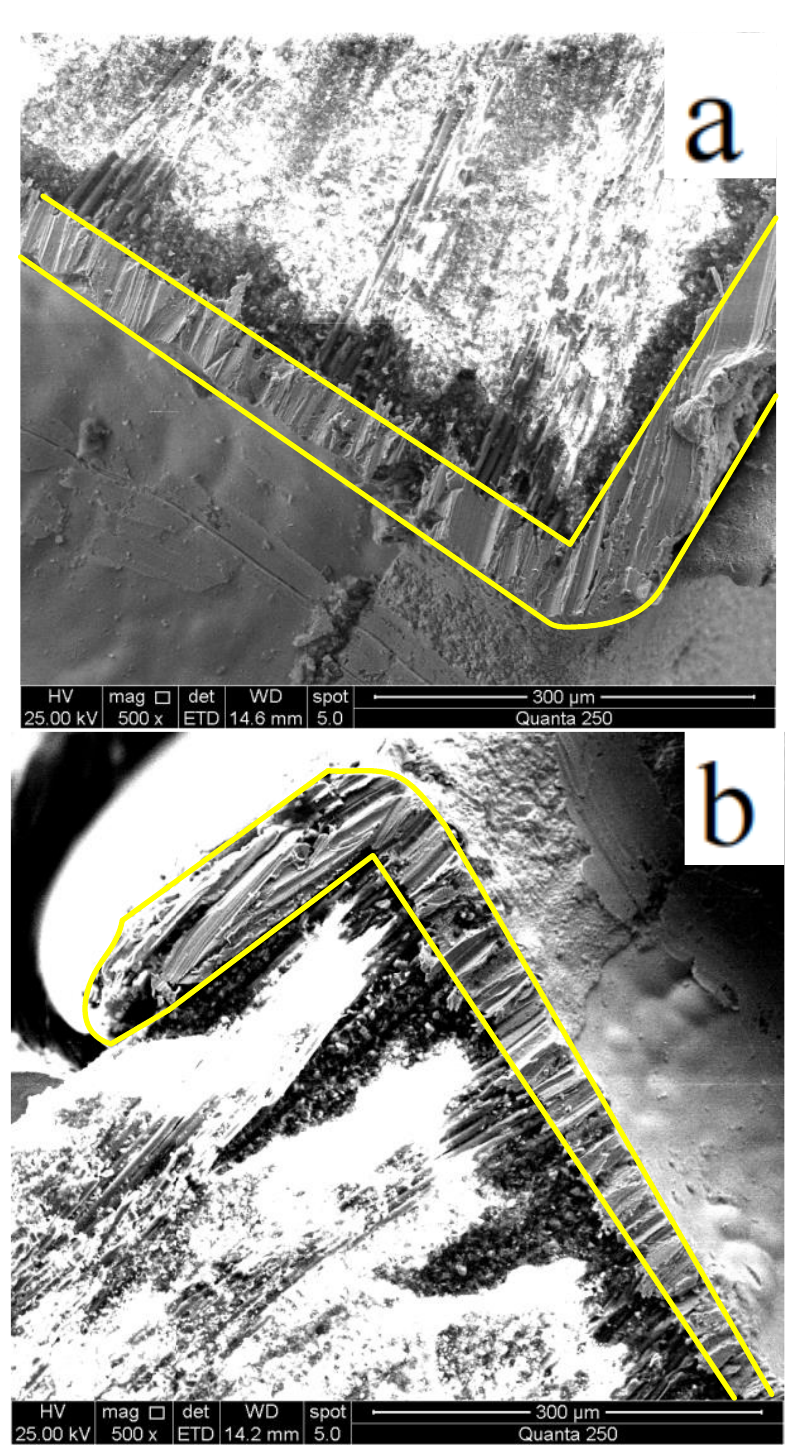
Figure 9. Cross-sectional view of via hole orifice under bidirectional pulse and DC plating.